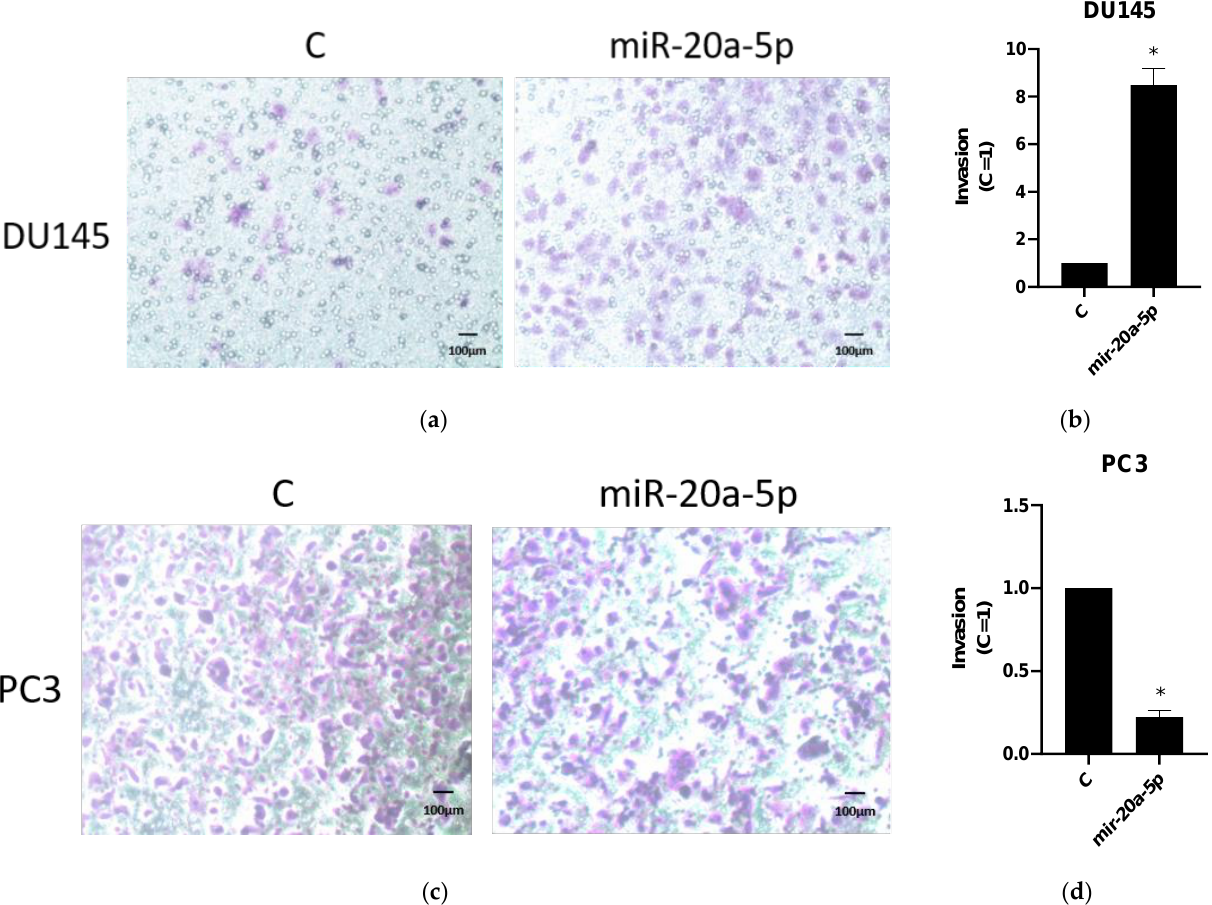
Figure 4. Invasion analysis of transfected miR-20a-5p cells compared to controls in PC3 and DU145 cell lines (representative of three experiments). DU145 cell lines showed significant ( p < 0.05) migration compared to controls. Results are plotted (mean ± SEM) in relation to controls (C = 1). Complete results from all experiments are presented in Supplementary Table S2. ( a , b ) Invasion assay for DU145 cell lines; ( c , d ) Invasion assay for PC3 cell lines. *Significantly different from control ( p < 0.05, Student t-test).